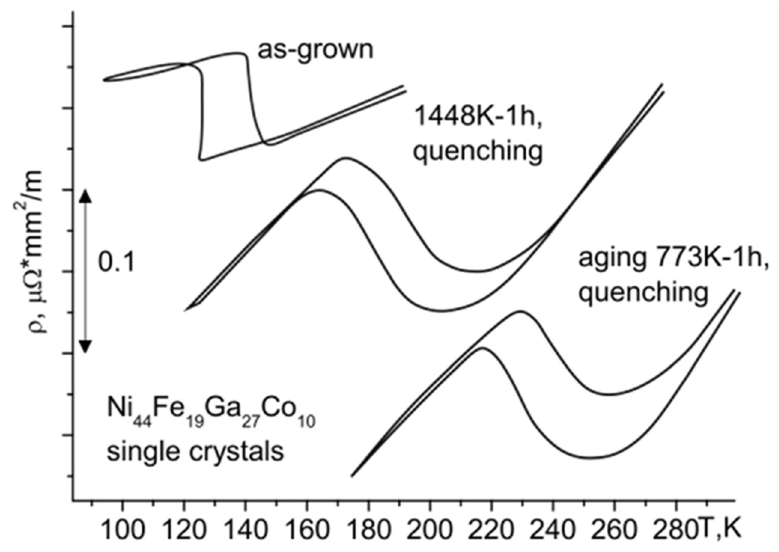
Figure 2. Temperature dependences of electrical resistance for Ni 44 Fe 19 Ga 27 Co 10 as-grown single crystals, for quenched and aged single crystals. Table 1. Characteristic MT temperatures for Ni 44 Fe 19 Ga 27 Co 10 as-grown single crystals, after quench- ing and aging.